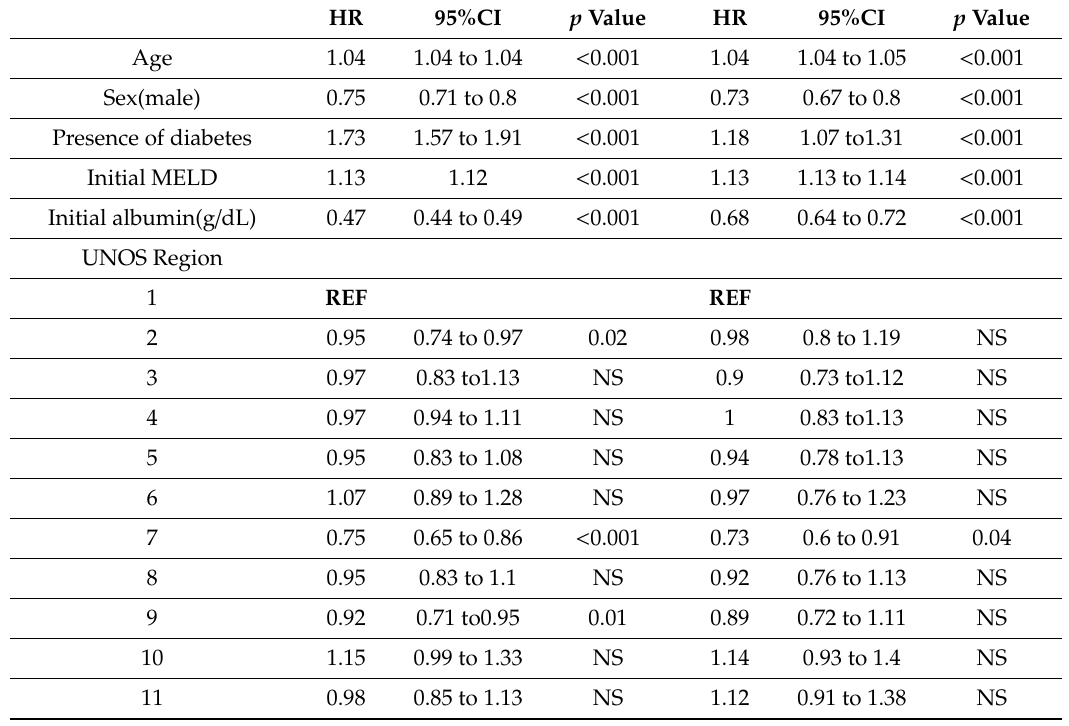
Table 3. Cox regression analysis for time to death or waitlist removal for clinical deterioration. REF: reference; HR: hazard ratio; NS: not significant; MELD: model for end stage liver disease;